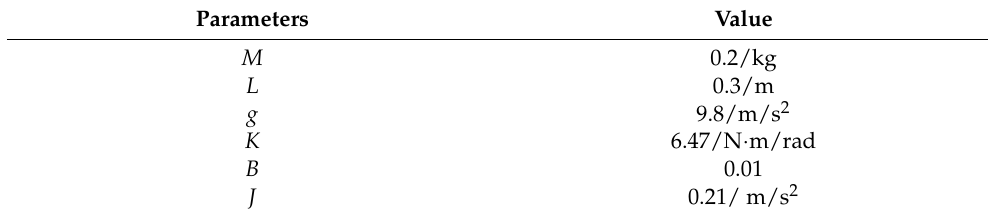
Table 1. Parameters of the flexible manipulator.